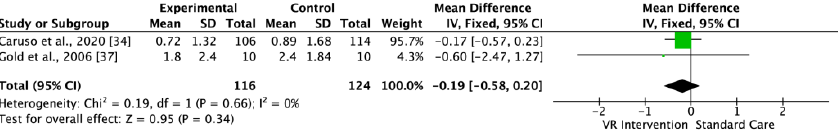
Figure 4. Comparison of VR treatment and standard care, pain (FPS-R). SD: standard deviation; 95% CI: 95% confidence interval; green square: mean difference; black rhombus: pooled effect.